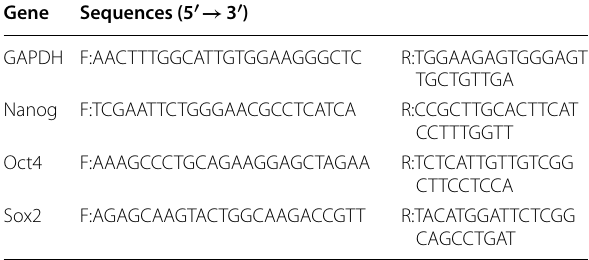
Table 1 RT-PCR primer sequences Gene Sequences (5 ′